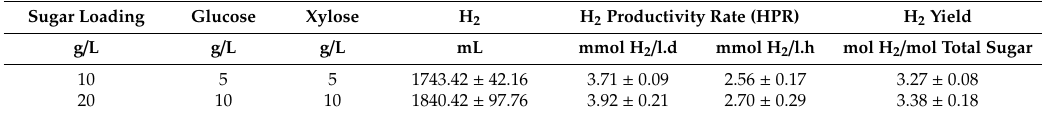
Table 2. Hydrogen productivity and H 2 yield obtained from each of the di ff erent sugar loadings.